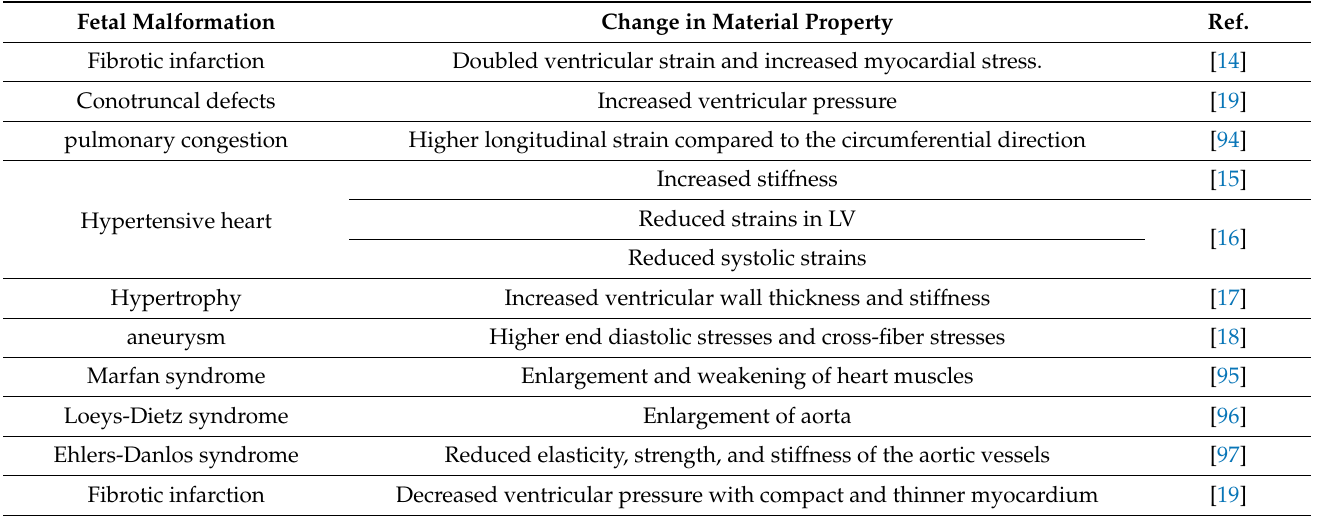
Table 6. General material property trends for selected cardiac malformations. CTB: conotruncal